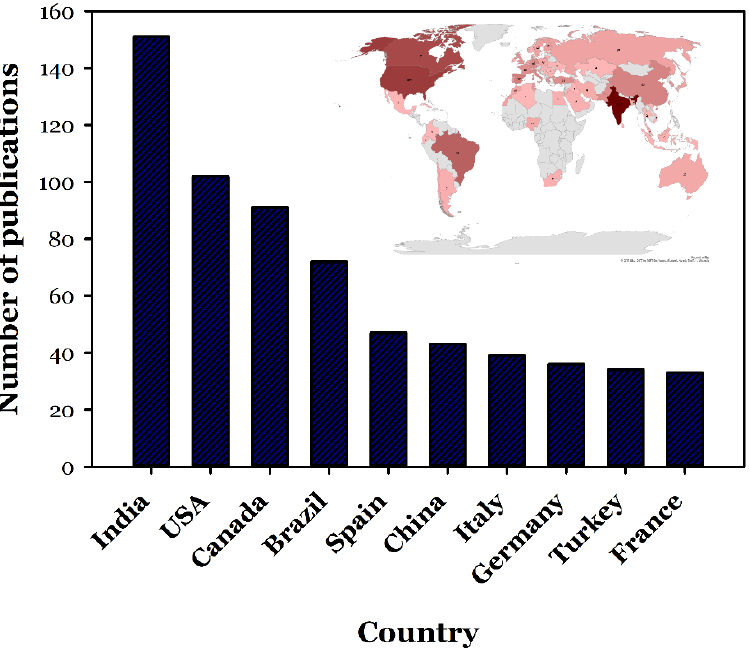
Figure 8. Countries that most contribute to the field of the industrial effluent and sludge toxicity analysis with their respective number of published documents over the adopted duration from 1951 to 2020. The most contributing countries in this field have been presented with a darker color in the map, and the variation in the utilized color demonstrates the number of contributions provided by different countries. Table 4. The analysis regarding the most contributing countries in the field of industrial effluent and sludge toxicity during the period of 1951 to 2020 via utilization of CiteSpace software. As can be observed in this table, India and the USA, with the total portion of 14.55% and 9.83%, respectively, have contributed the most in publishing scientific documents in the field of toxicity analysis of industrial effluents from the numeric perspective. Moreover, by comparing the corresponding population ratio, Canada has shown a more productive behavior in publishing the scientometric publications in this regard.